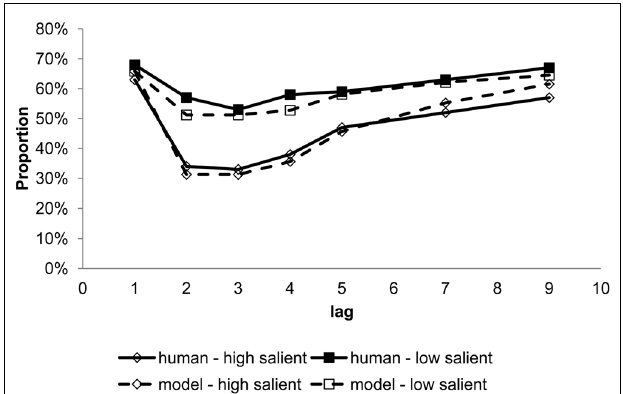
FIGURE 5 |Target report accuracy by serial position comparing human data (Barnard et al., 2004) and model simulation for both high and low salient key-distractors. Lag indicates the number of items intervening between the key-distractor and the